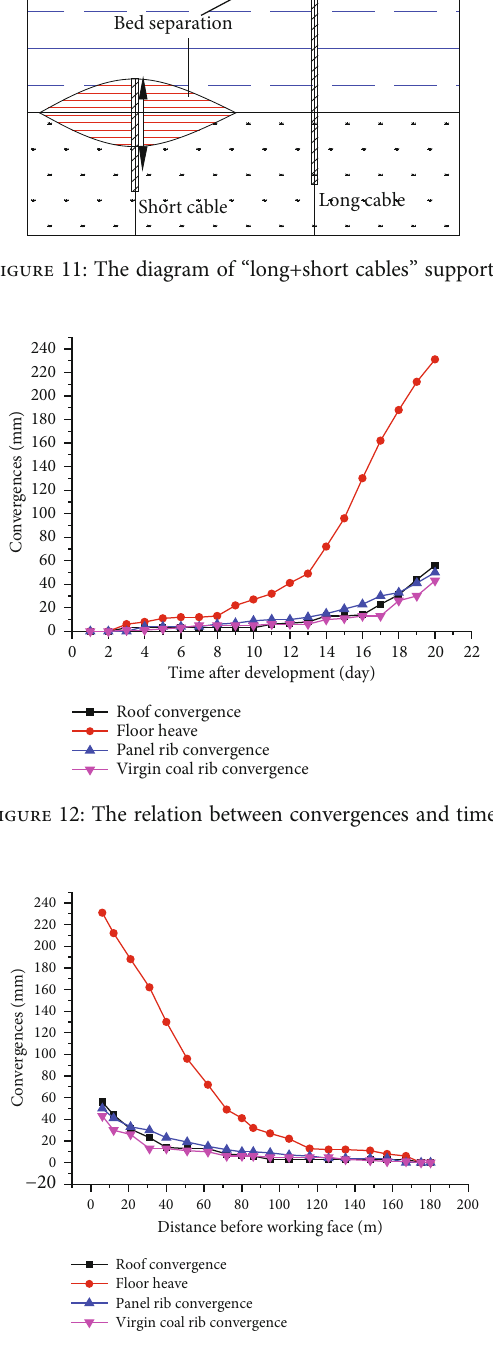
Figure 13: The relation between convergences and distance before working